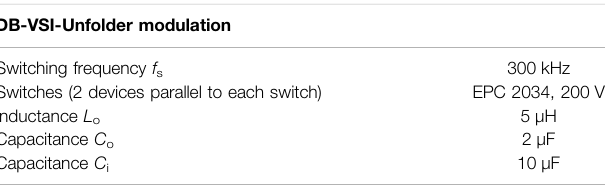
TABLE 3 | DB-VSI hardware prototype parameters corresponding to the schematic diagram notation of Figure 4 . DB-VSI-Unfolder modulation